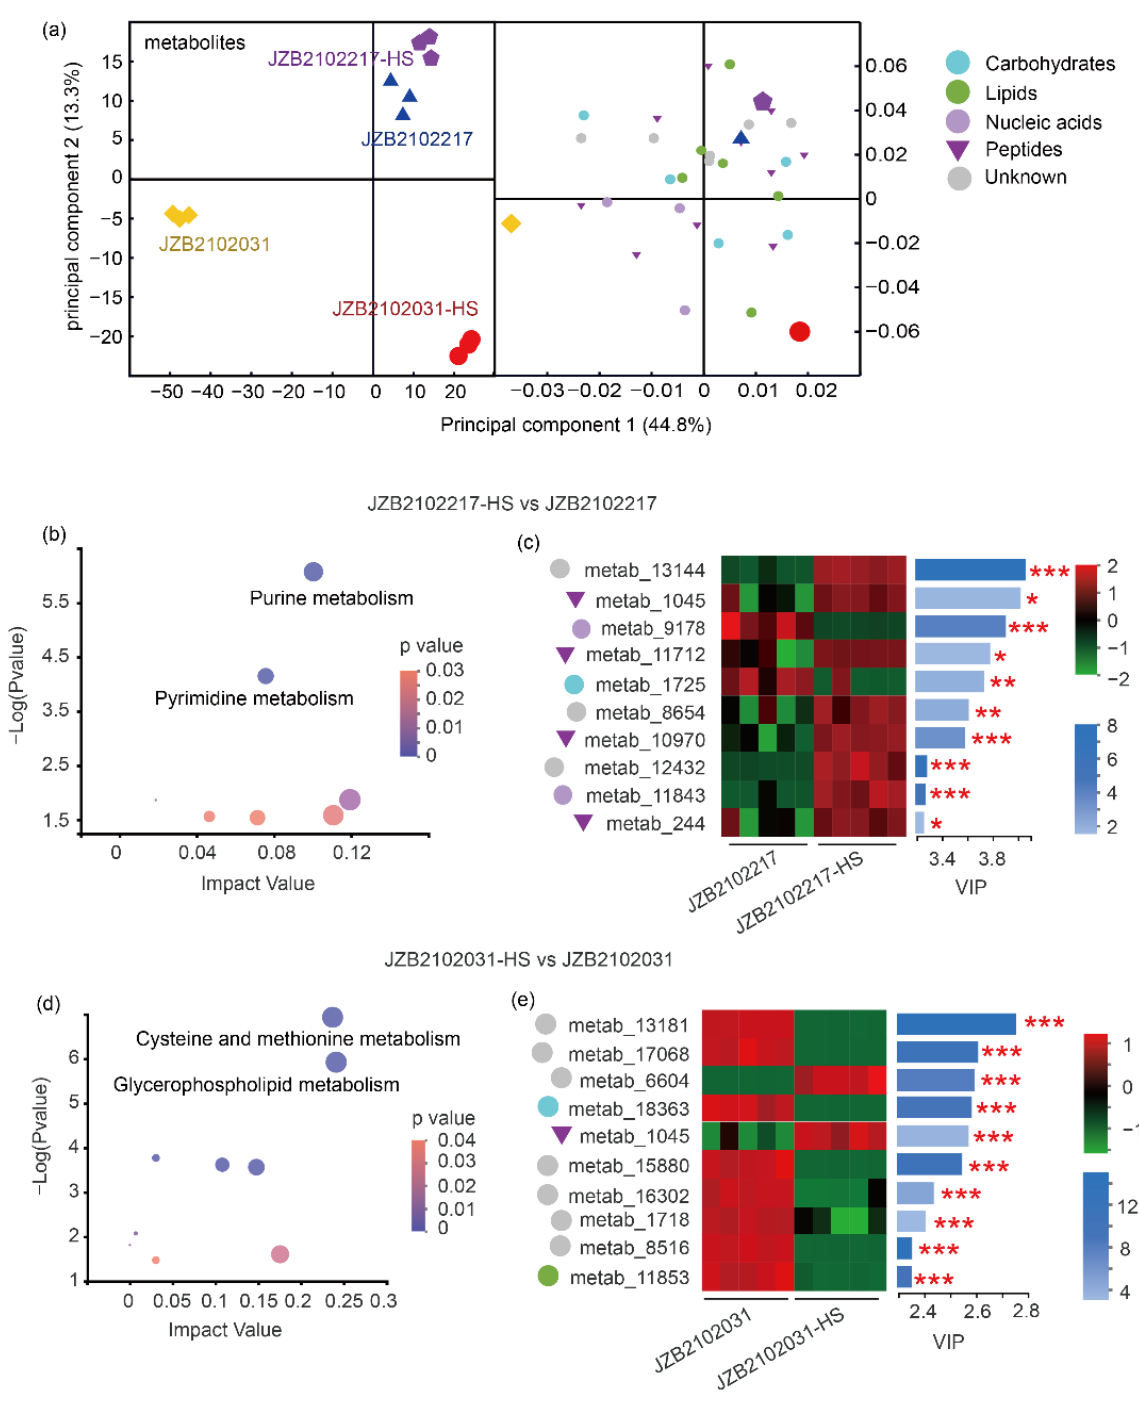
Figure 4. Metabolic profiling of H-type L. edodes strain JZB2102217 and L-type strain JZB2102031 in response to heat stress. ( a ) OPLS-DA analysis of the metabolome data of all samples (R2Xcum = 0.857, R2Ycum = 0.98, Q2cum = 0.899, CV-ANOVA, p = 2.083 × 10 − 11 ). Loading plot shows the top 30 metabolites (VIP > 1); ( b , c ) the KEGG topology analysis of DEMs and top 10 metabolites in H-type strain in response to heat stress (37 ◦ C), respectively; ( d , e ) the KEGG topology analysis of DEMs and top 10 metabolites in L-type strain in response to heat stress (37 ◦ C), respectively. The color of the blue bar indicates the value of -log10 ( p -value); *, **, and *** indicate the abundance of compounds that were significant at p value < 0.05, <0.01, and <0.001,